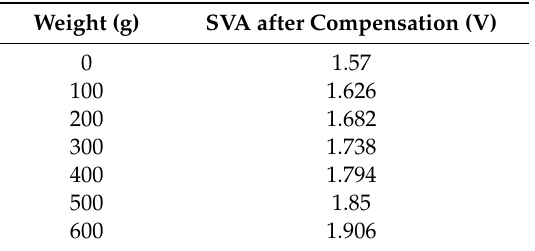
Table 1. Weights and SVAs after compensation.